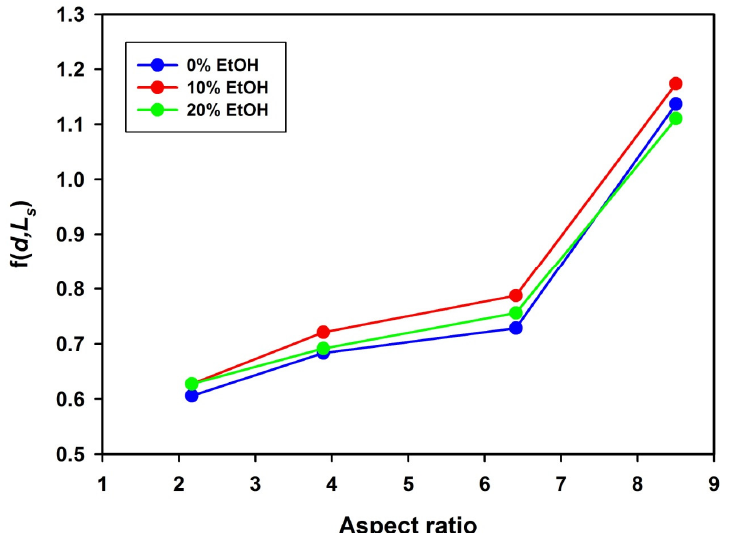
Figure 8. Plots of f( d , L s ) as function of aspect ratio for microspheroidal P(S/PGL) particle